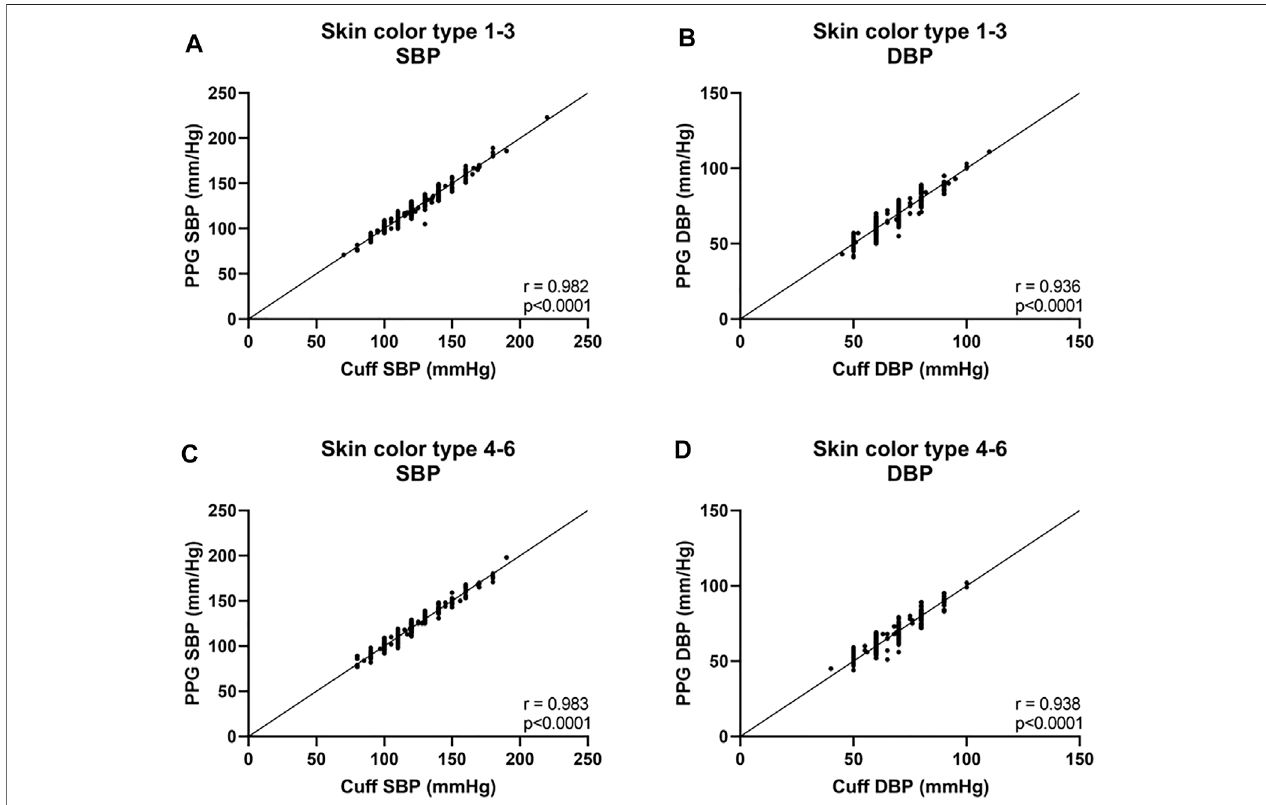
FIGURE 6 | Correlation curves of the body ’ s skin color are based on the Fitzpatrick color scale (Fitzpatrick, 1988). Type 1 — always burns, never tans, palest, can have freckles; Type 2 — usually burns, tans minimally, light-colored but darker than fair; Type 3 — sometimes mild burn, tans uniformly, golden honey or olive; Type 4 — burnsminimally,alwaystanswell,moderatebrown;Type5 — veryrarelyburns,tansveryeasily,darkbrown;andType6 — neverburns,deeplypigmenteddarkbrown to darkest brown. SBP systolic blood pressure, DBP diastolic blood